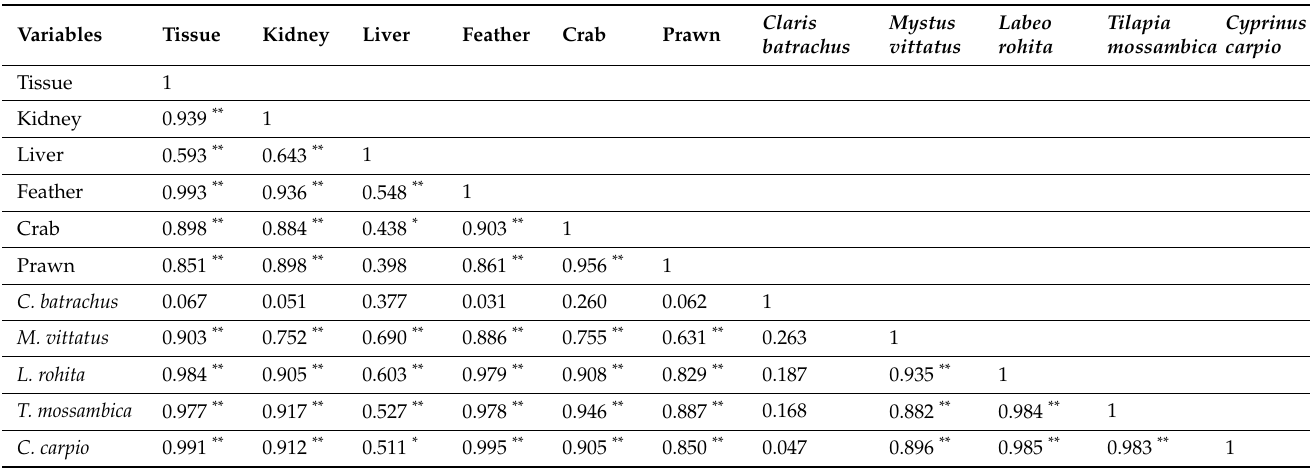
Table 4. Pearson Correlation of different metals assessed between the various organs of the Indian pond heron ( Ardeola grayii ) and their prey species (bold letter with * indicate the level of significance is p < 0.05; with ** indicates the level of significance at p < 0.001).